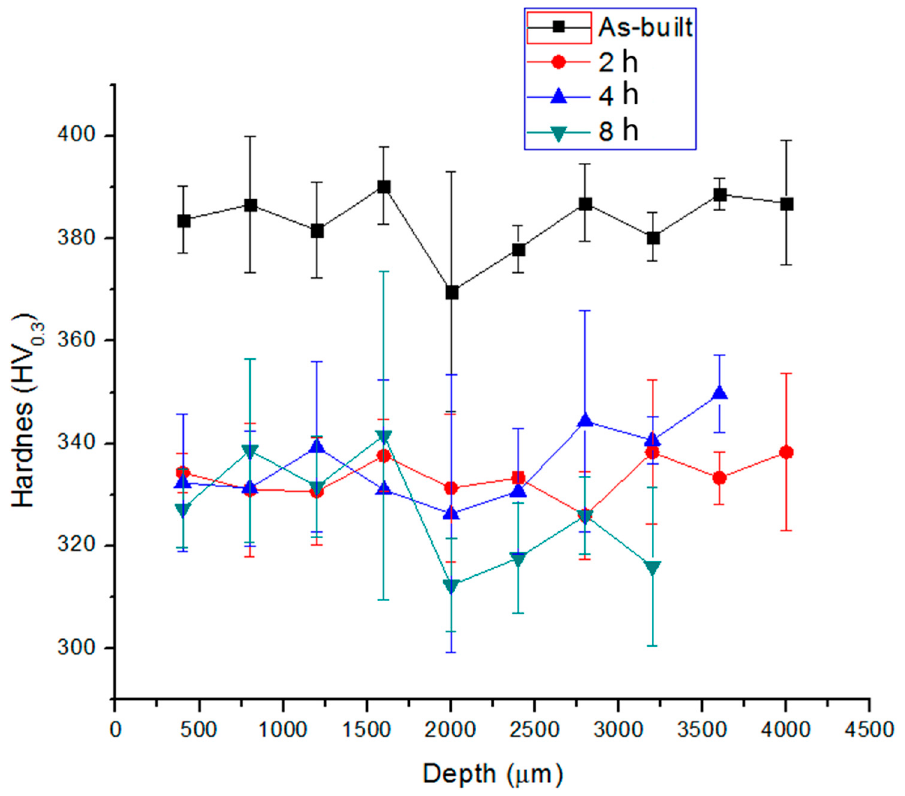
Figure 8. Hardness profiles of the as-built and heat-treated samples after heat treatment at various residence times.